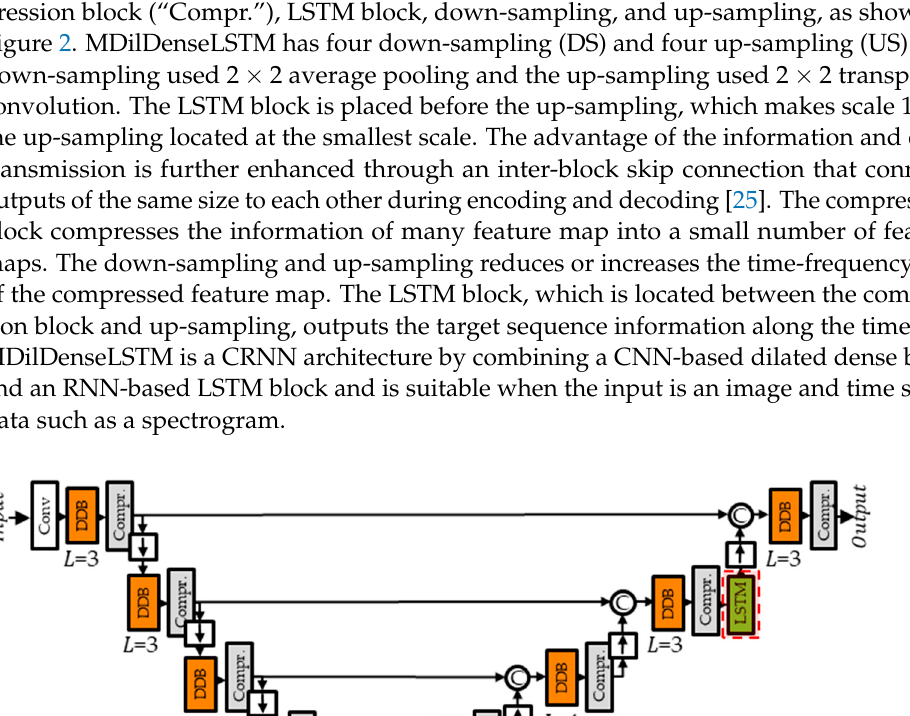
Figure 1. The architecture of dilated dense block. The [frequency, time] denotes the kernel size and dilation rate. BN: batch normalization, ReLU: rectified linear unit, FDConv: frequency dilated con- volution, TDConv: time dilated convolution.